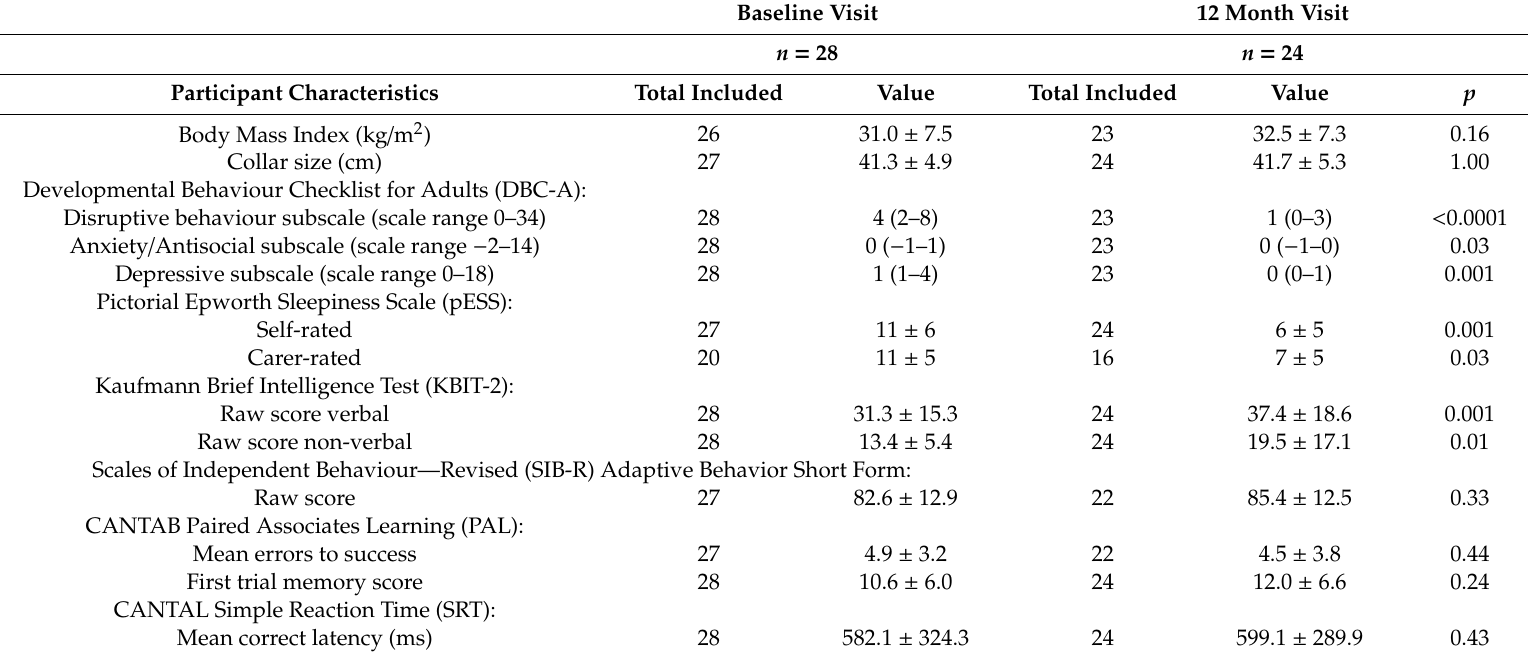
Table 2. Comparison of whole group at baseline and 12 months (mean ± SD or median (IQR) as appropriate). Baseline Visit 12 Month Visit n = 28 n = 24 Participant Characteristics Total Included